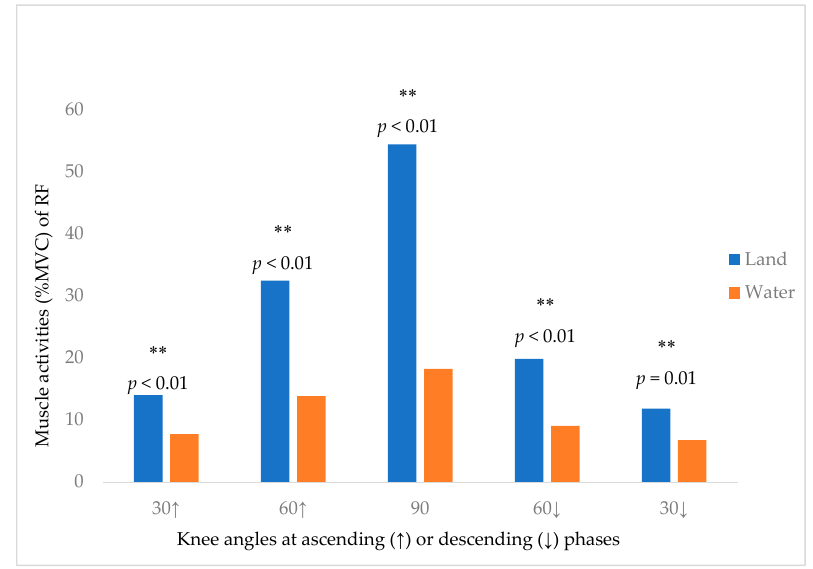
Figure 4. The Muscle Activity of RF (%MVC) at different knee angles (degree) during squatting. ** significant at p < 0.01; ( ↑ ) ascending phase; ( ↓ ) descending phase .